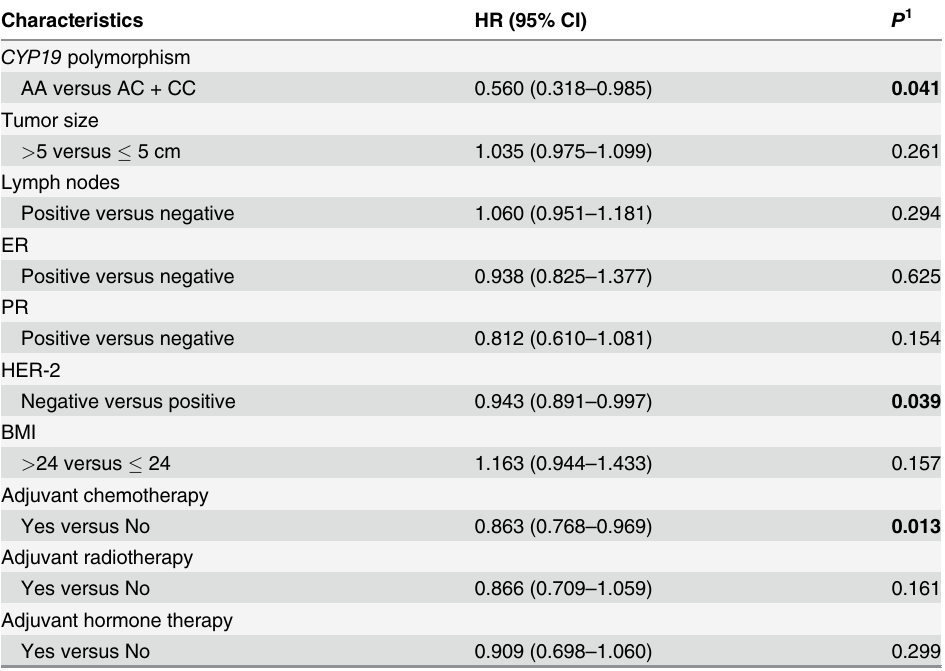
Table 4. Multivariate analysis of prognostic factors and DFS for premenopausal